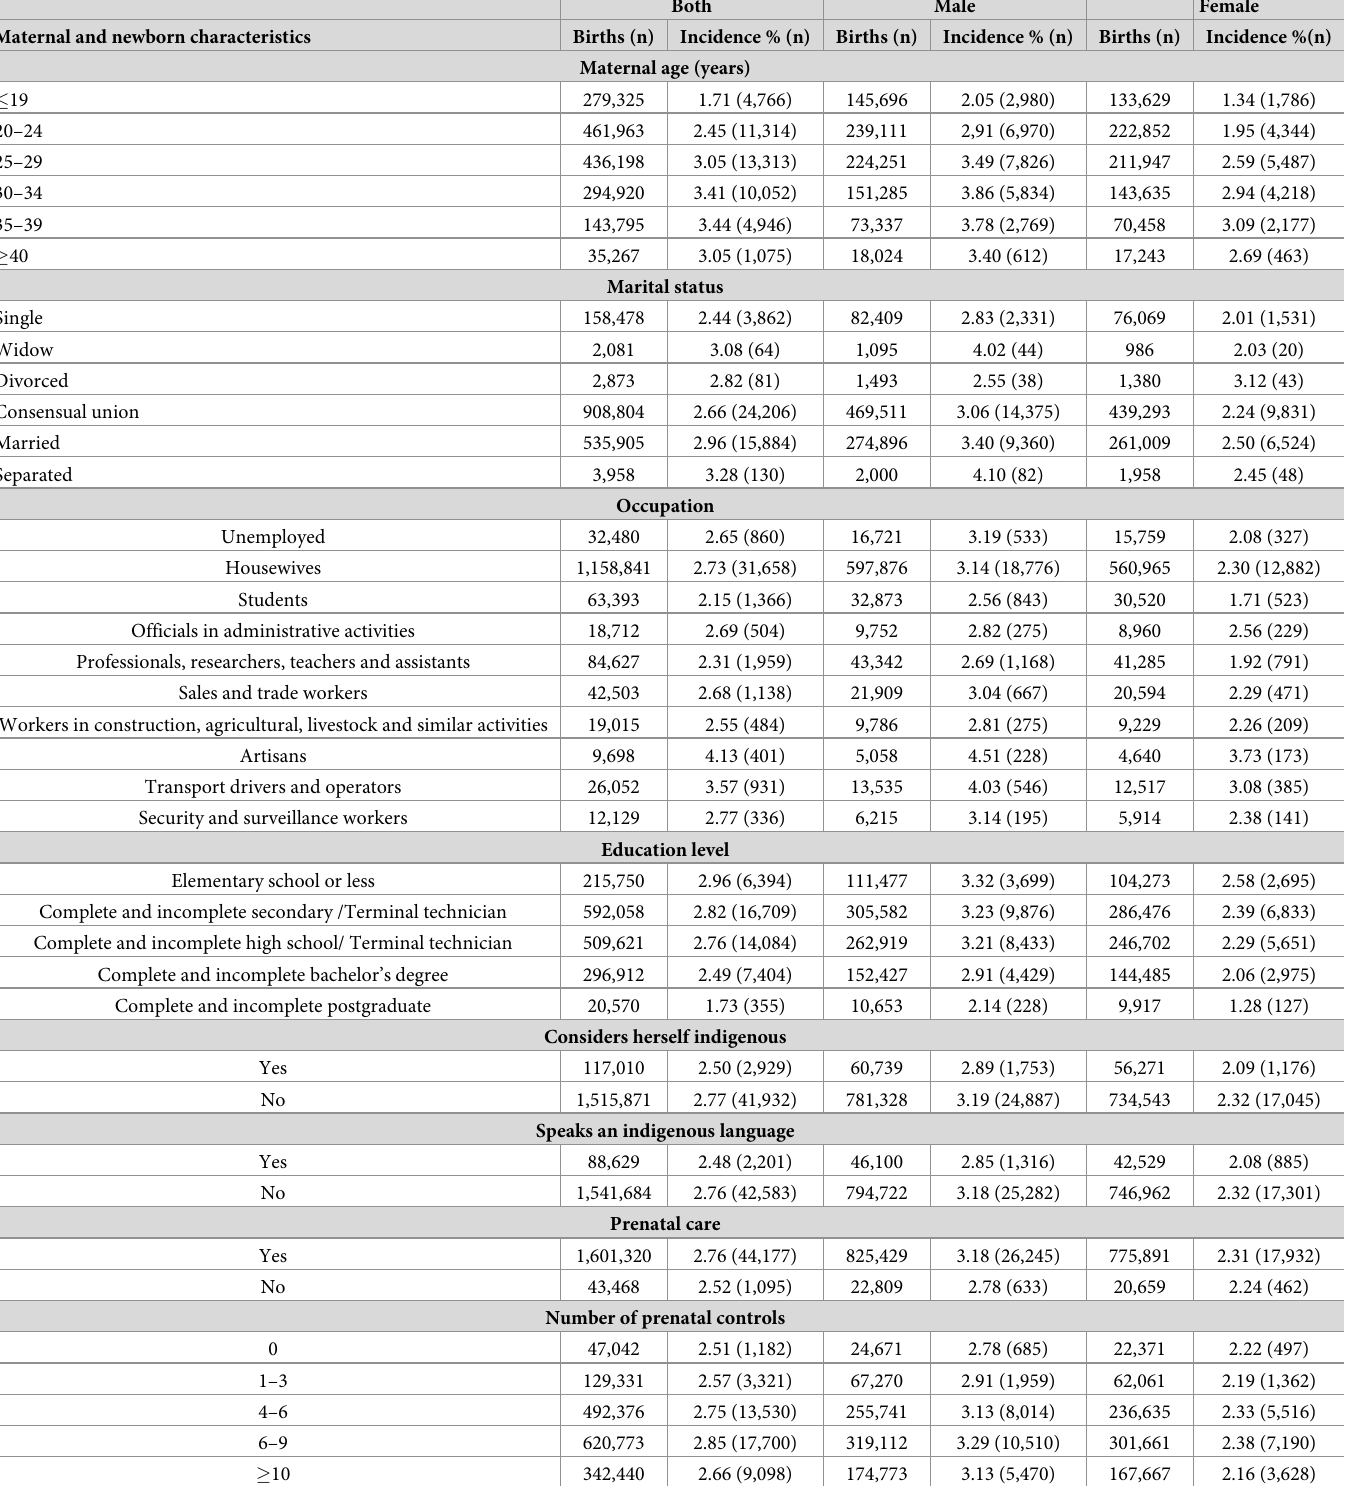
Both Male Female